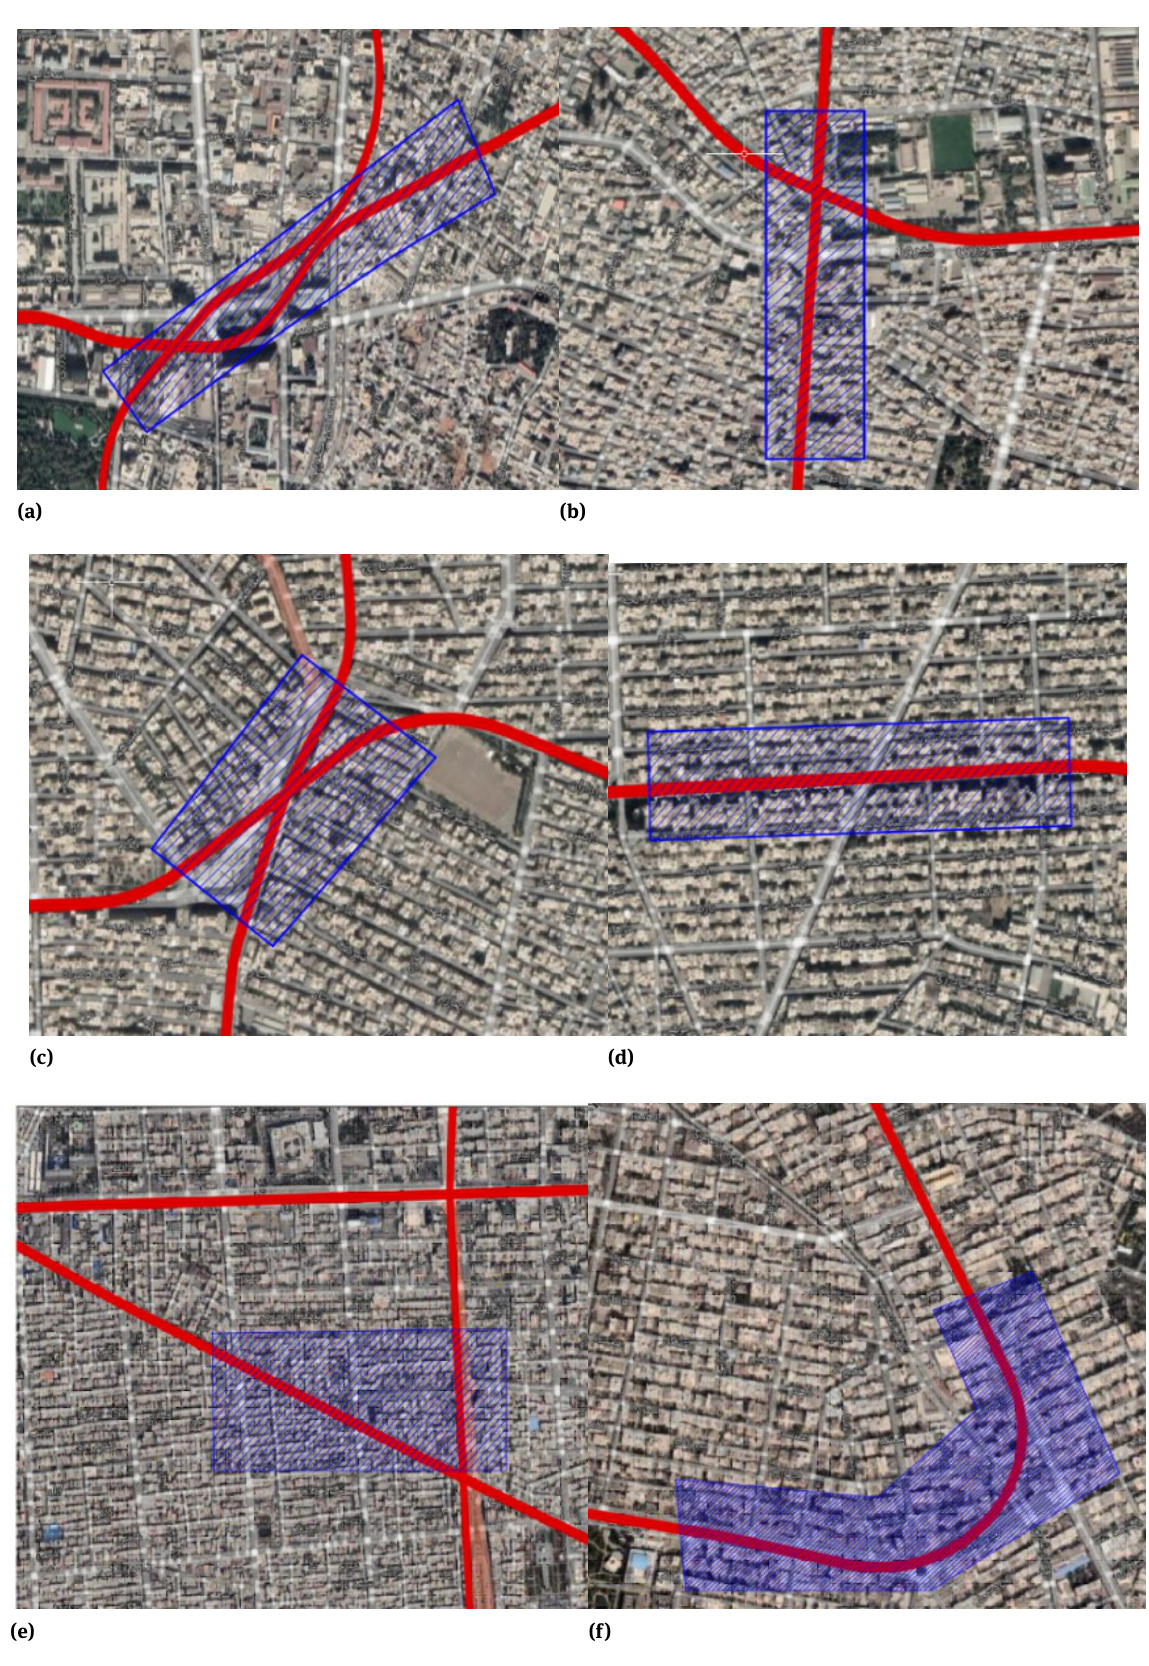
Figure 5: Location of test zones (hatched area) vs. tunnel axis (red lines), (a) test zone 1, (b) test zone 2, (c) test zone 3, (d) test zone 4, (e) test zone 5 and (f) test zone